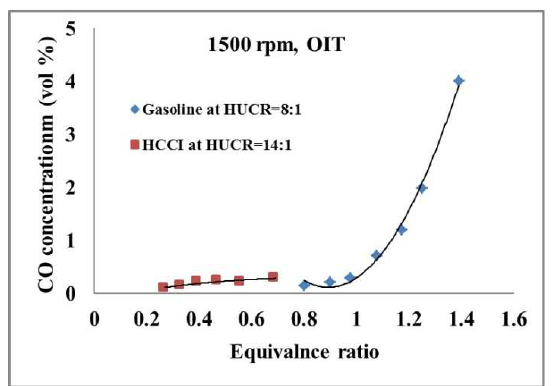
Fig. 14. UBHC concentrations of the two systems at HUCR for each one, for wide range of equivalence ratio.